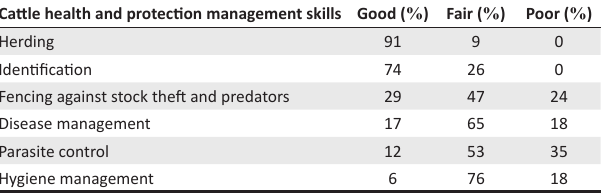
TABLE 3: Skills relevant to cattle health and protection